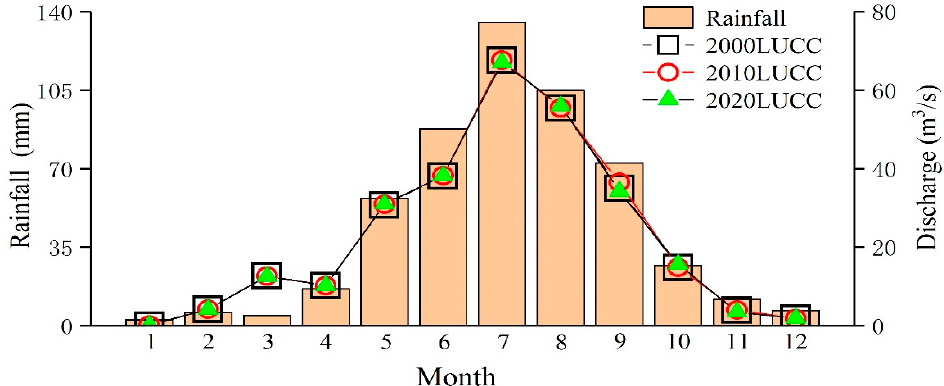
Figure 15. Map of monthly runoff volume changes under the three land use phases.